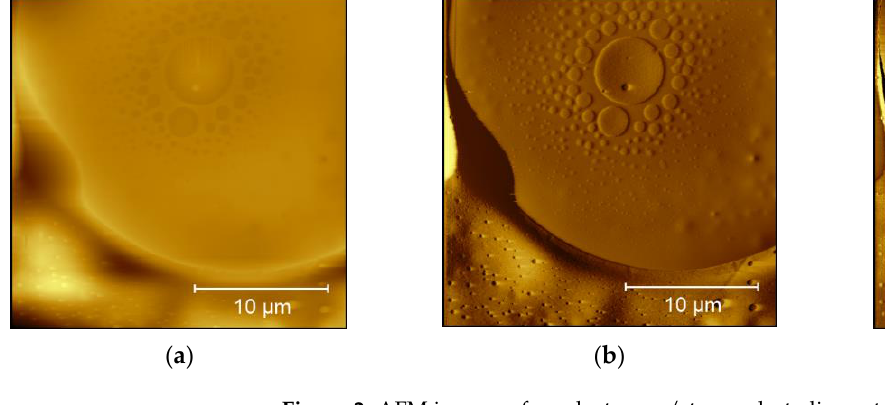
Figure 2. AFM images of a polystyrene/styrene-butadiene-styrene block-copolymer (PS/SBS) blend with higher resolution: ( a ) topography (height range 1.0 µ m); ( b ) amplitude; ( c ) phase image (phase range 55 ◦ without the black area which was not correctly